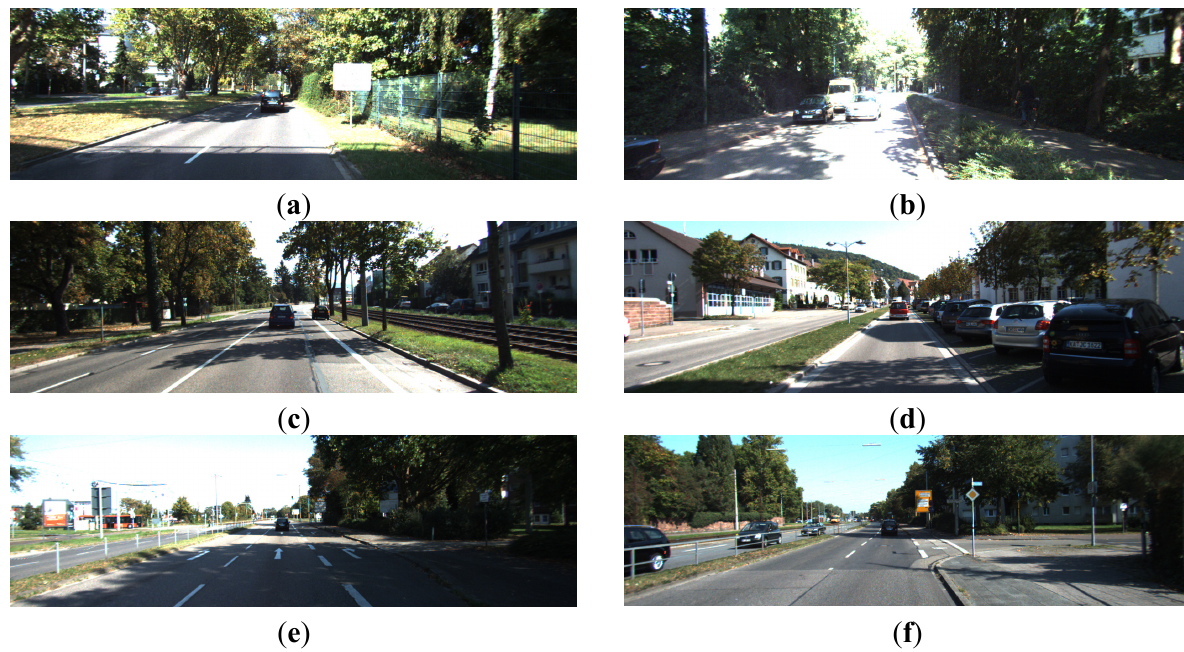
Figure 2. Curb images. ( a ) Curbs in illumination change; ( b ) Curbs in shadow; ( c ) Curbs